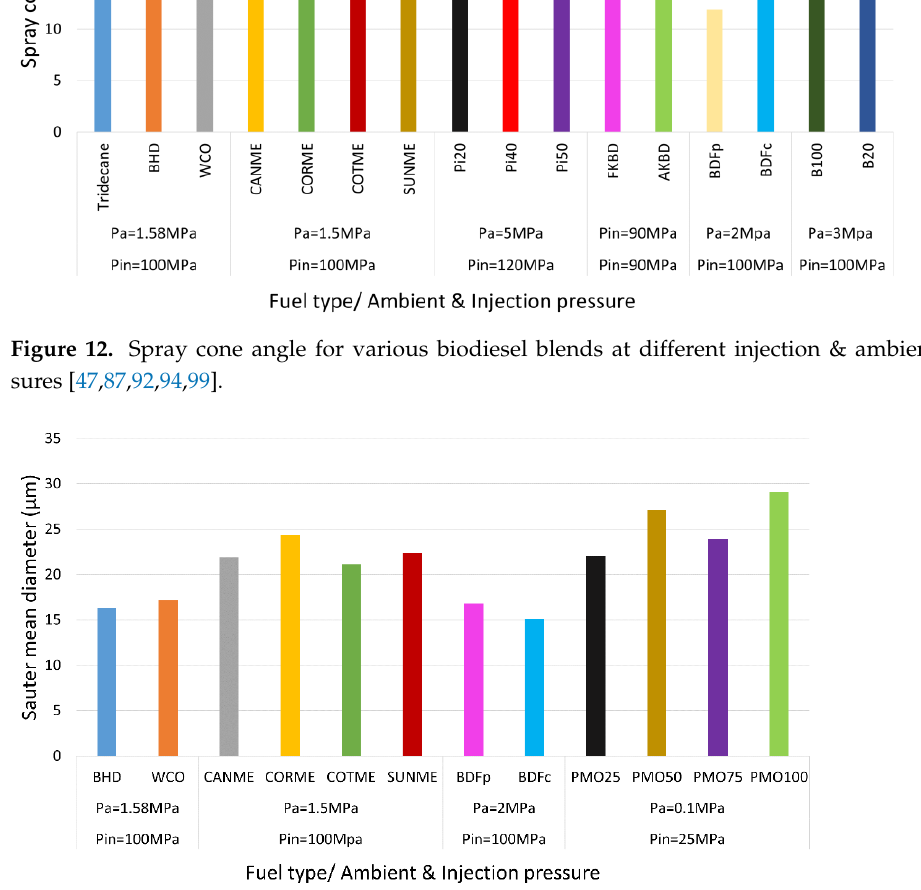
Figure 13. SMD for various biodiesel blends at different injection & ambient pressures [87,92,93,98,99]. Table 5. Properties of biodiesel derived from various feedstocks [91,100,101].